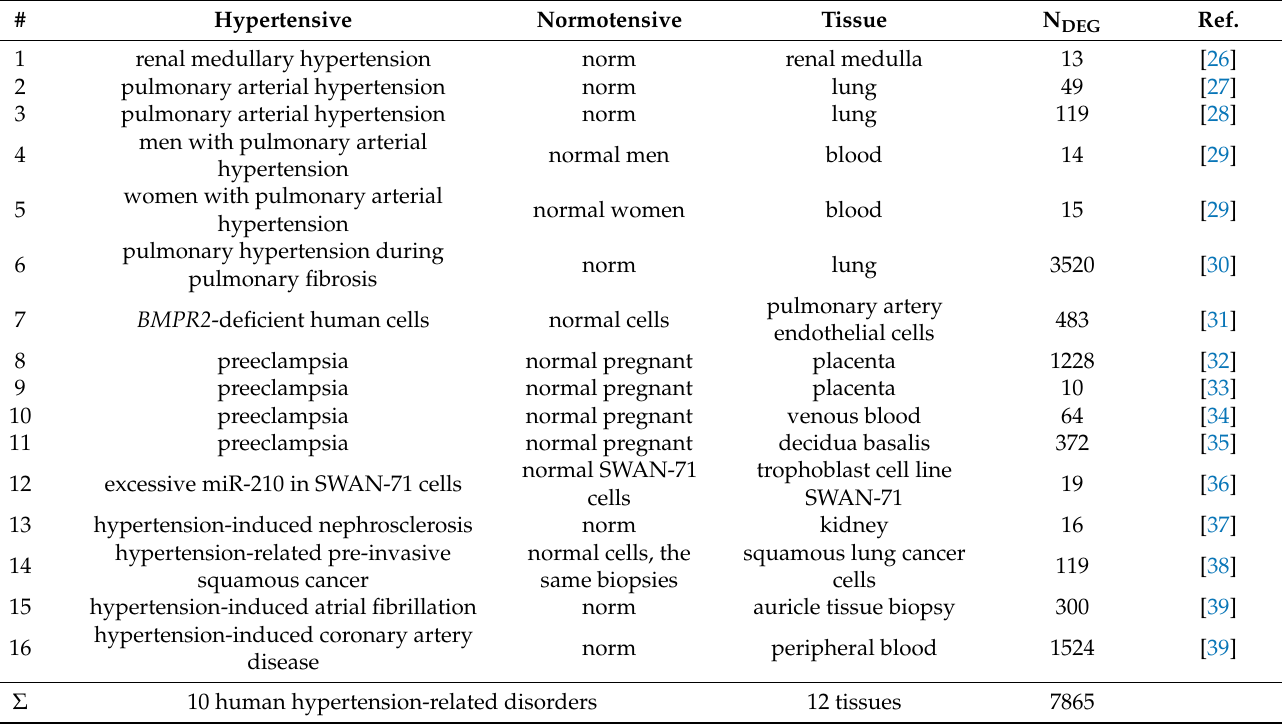
Table 5. The analyzed DEGs—of hypertensive versus normotensive patients—that we could find (available in PubMed